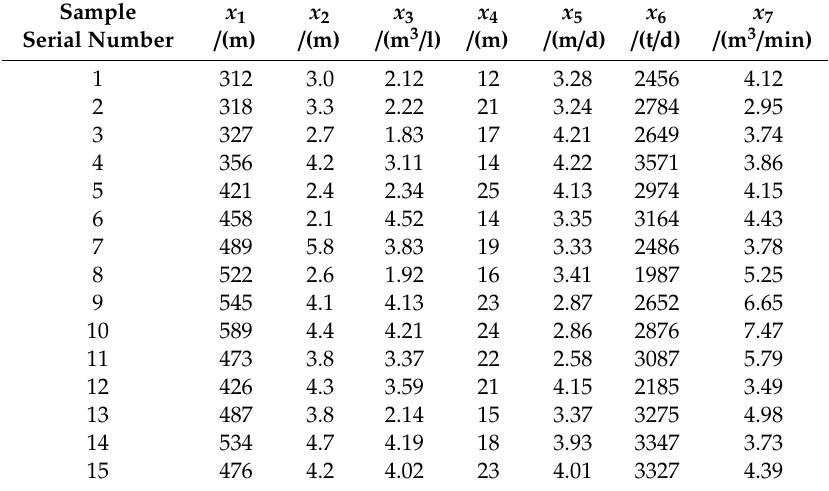
Table 1. Methane sample data.